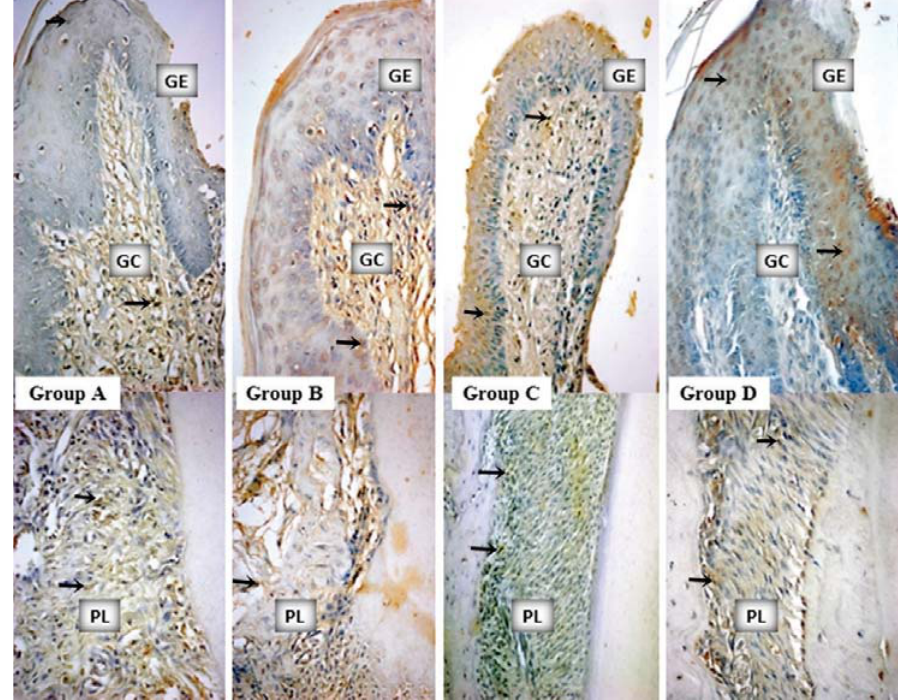
Figure 4- (cid:3)(cid:48)(cid:72)(cid:86)(cid:76)(cid:68)(cid:79)(cid:3)(cid:74)(cid:76)(cid:81)(cid:74)(cid:76)(cid:89)(cid:68)(cid:3)(cid:73)(cid:85)(cid:82)(cid:80)(cid:3)(cid:87)(cid:75)(cid:72)(cid:3)(cid:69)(cid:88)(cid:70)(cid:70)(cid:68)(cid:79)(cid:177)(cid:79)(cid:76)(cid:81)(cid:74)(cid:88)(cid:68)(cid:79)(cid:3)(cid:86)(cid:72)(cid:70)(cid:87)(cid:76)(cid:82)(cid:81)(cid:86)(cid:3)(cid:82)(cid:73)(cid:3)(cid:80)(cid:68)(cid:81)(cid:71)(cid:76)(cid:69)(cid:88)(cid:79)(cid:68)(cid:85)(cid:3)(cid:191)(cid:85)(cid:86)(cid:87)(cid:3)(cid:80)(cid:82)(cid:79)(cid:68)(cid:85)(cid:86)(cid:17)(cid:3)(cid:55)(cid:42)(cid:41)(cid:16)(cid:533)(cid:3)(cid:86)(cid:87)(cid:68)(cid:76)(cid:81)(cid:76)(cid:81)(cid:74)(cid:3)(cid:86)(cid:68)(cid:80)(cid:83)(cid:79)(cid:72)(cid:86)(cid:3)(cid:73)(cid:85)(cid:82)(cid:80)(cid:3)(cid:87)(cid:75)(cid:72)(cid:3)(cid:86)(cid:87)(cid:88)(cid:71)(cid:92)(cid:3)(cid:74)(cid:85)(cid:82)(cid:88)(cid:83)(cid:86)(cid:3)(cid:11)(cid:91)(cid:23)(cid:19)(cid:15)(cid:3) diaminobenzidine). Arrows indicate the stained cells. GE: gingival epithelium, GC: gingival connective tissue, PL: periodontal ligament Table 4- HScore values for intragroup comparisons of IL-10 and TGF-ß in the study groups (GE: Gingival epithelium; GC: Gingival Connective Tissue; PL: Periodontal Groups Paired areas